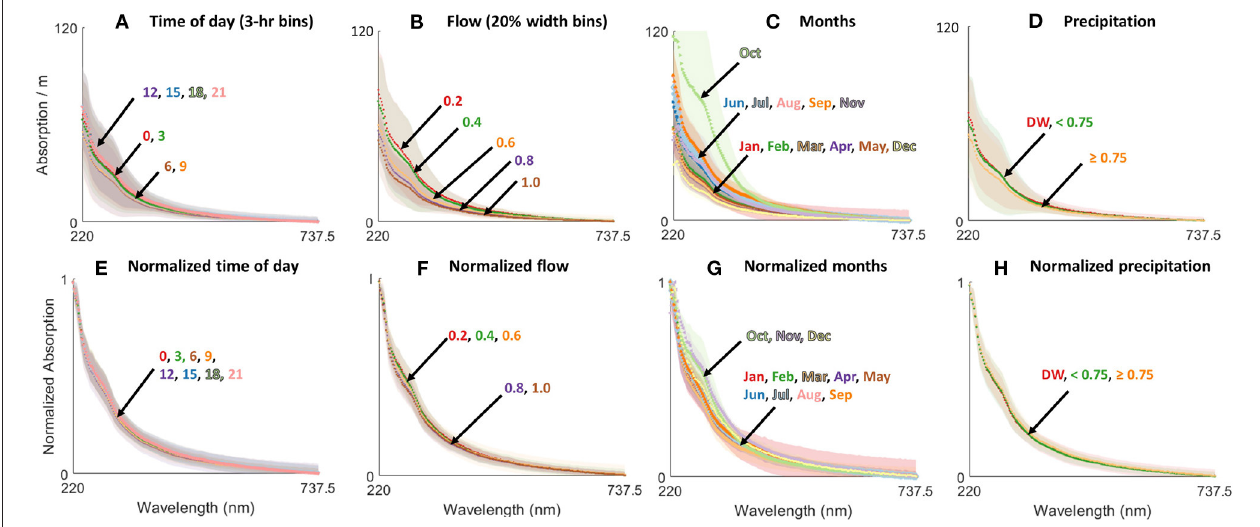
FIGURE 1 | Average wastewater spectra categorized by the following factors; (A) time of day (3-h bins), (B) flow (20% width bins), (C) month, and (D) precipitation (DW is dry weather, numbers are in/h). Normalized spectra categorized by the following factors; (E) time of day, (F) flow, (G) month, and (H) precipitation with binning as for (A–D) .